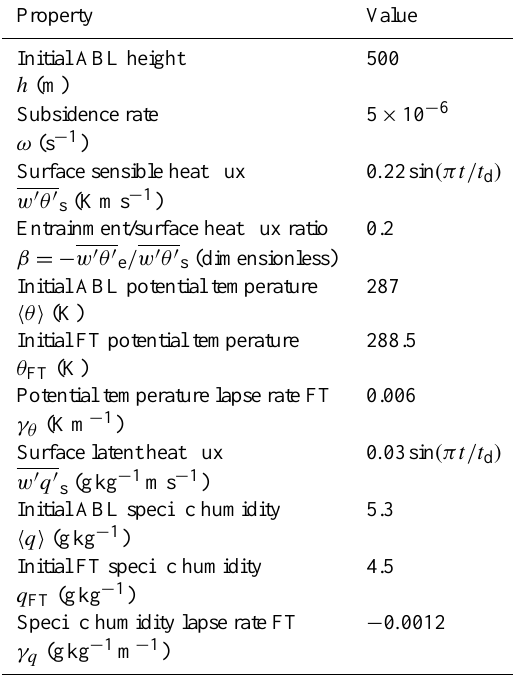
Table A1. The initial and boundary conditions in the atmospheric boundary layer (ABL) and free troposphere (FT) as used in MXL/MESSy and MXLCH. All initial conditions are imposed at 07:00LT. t is the time elapsed since the start of the simulation (s) and t d the length of the simulation (s). The subscripts s and e indicate values at the surface and the entrainment zone, respectively.